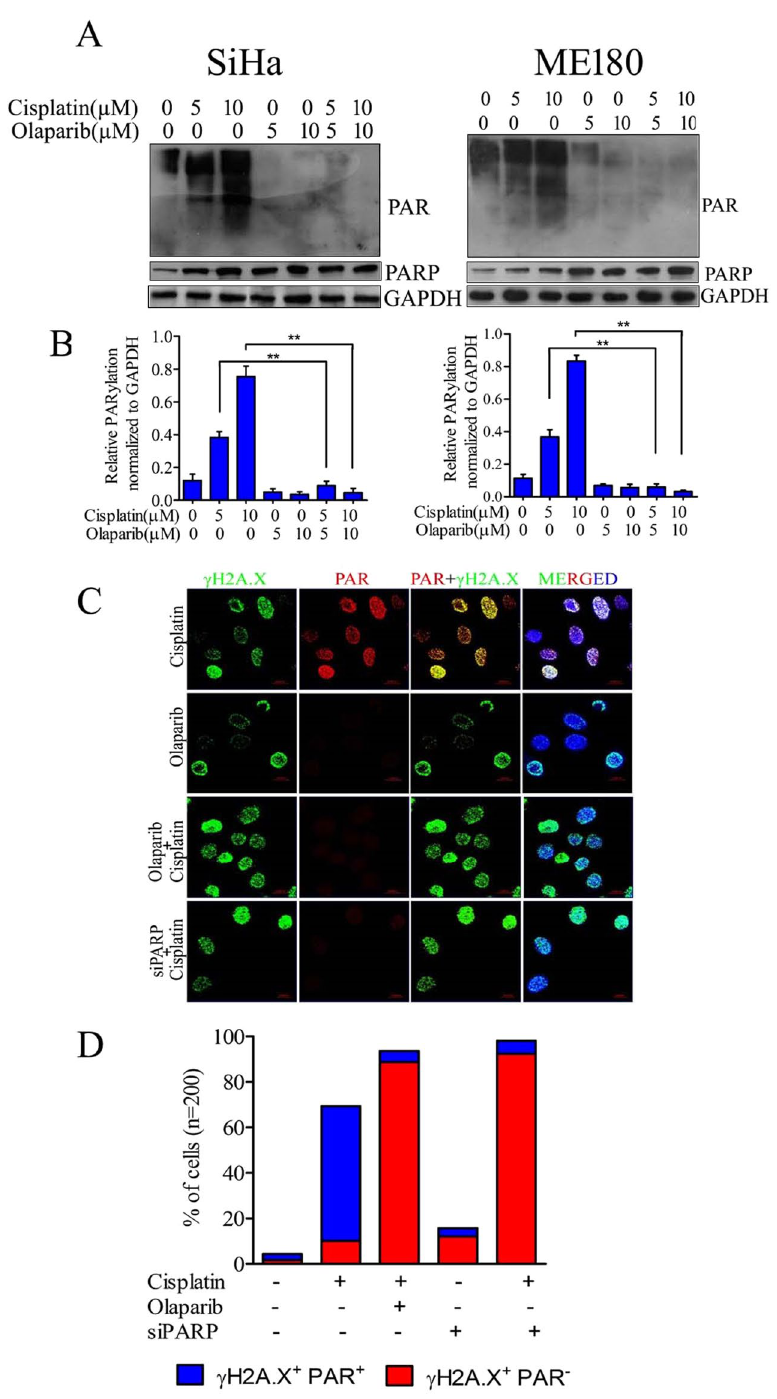
Figure 3. Effect of olaparib on cisplatin mediated PARP1 hyperactivation. ( A ) SiHa and ME180 cells were treated with cisplatin and/or olaparib for 48 hrs and expression of PARP1 and PAR was determined by western blot. Olaparib exerts strong anti-PARP activity in cisplatin treated CC cells.The full size blots corresponding to the cropped blot images are given in Supplementary Figure S12. ( B ) Bar graph displaying relative PARylation normalized to GAPDH in both cell lines. Error bars display the S.D. from the mean of 3 independent experiments. ** p = 0.0095. ( C ) Representative immunofluorescence image showing nuclear co-localization of PAR polymers with γ H2A.X foci. 24 hr cisplatin treated cells show higher PAR polymers signals compare to untreated and signal was completely suppressed after olaparib treatment or PARP1 siRNA transfection. ( D ) Bar graph displaying quantification of γ H2A.X + PAR − or γ H2A.X + PAR + cell distribution in cisplatin and/or olaparib treated along with PARP1 silenced cells treated with